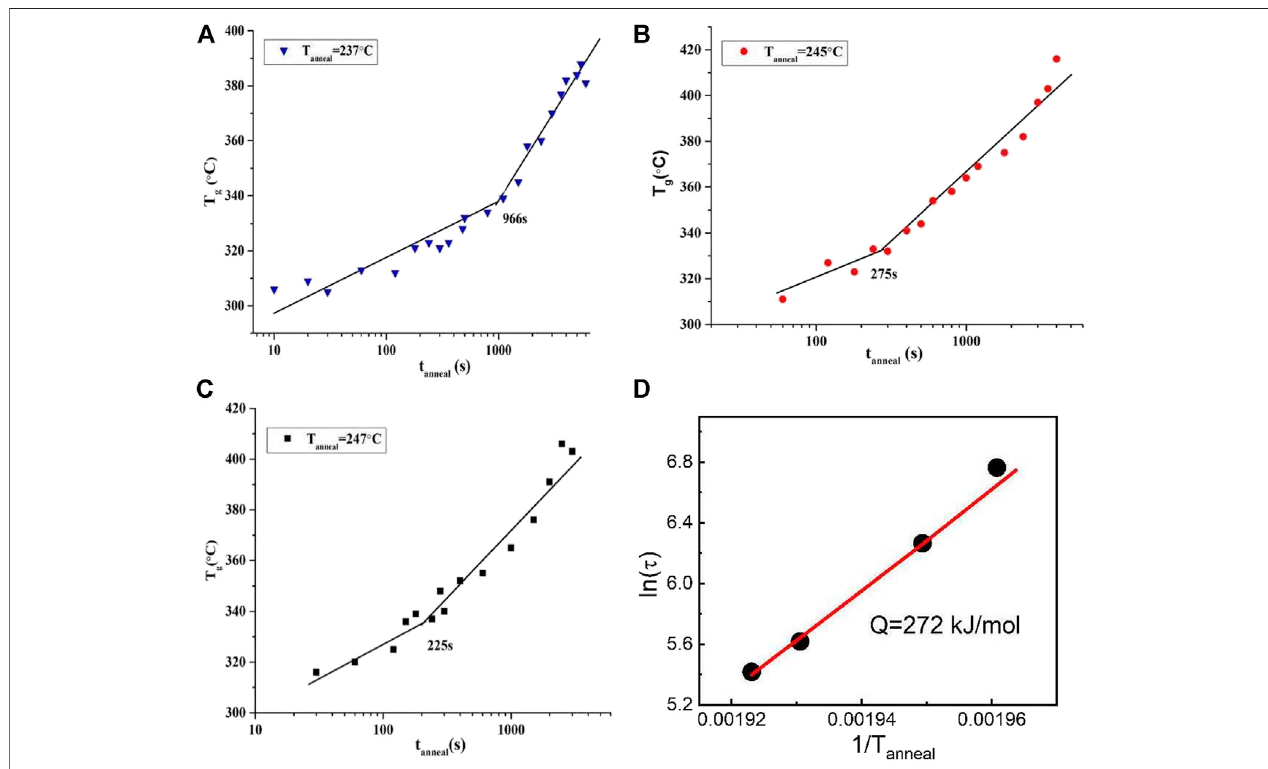
FIGURE5| Tgvs.log(tanneal)plotforAl 88 Y 7 Fe 5 atTanneal (A) 237 ° C (B) 245 ° C (C) 247 ° C(fromShenetal.(2019)) (D) DelaytimeactivationenergyQby fi ttingthe (cid:3) Equation τ (cid:2) τ 0 exp (cid:1) Q RT